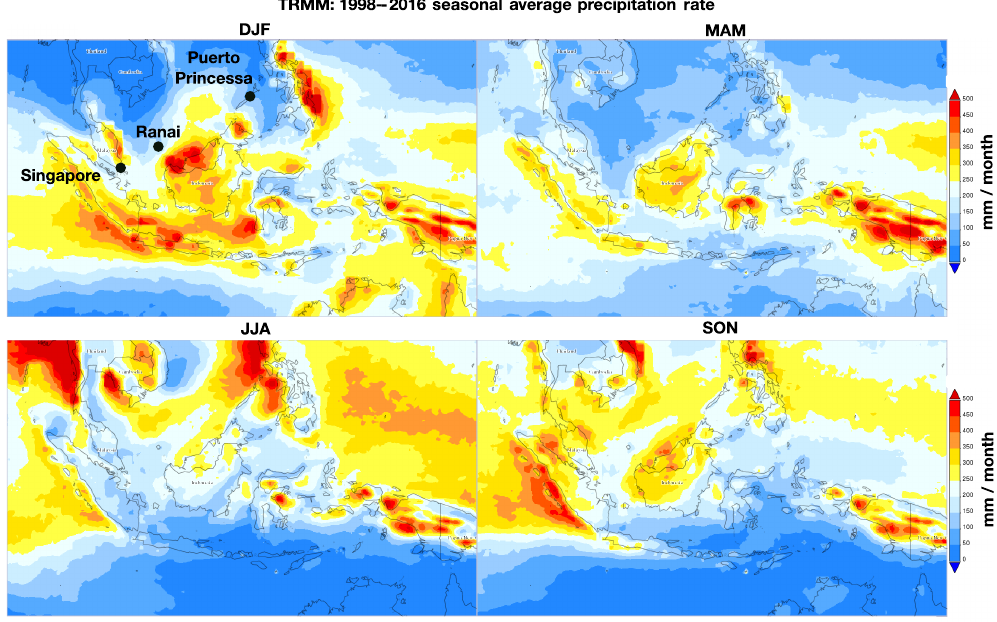
Figure 1. TRMM 1998–2016 seasonally averaged precipitation for the Maritime Continent. Seasonal variability is apparent and highly localized. Upper-air sounding sites used in the analysis are labeled and circled in black in the first panel and are most representative of the South China